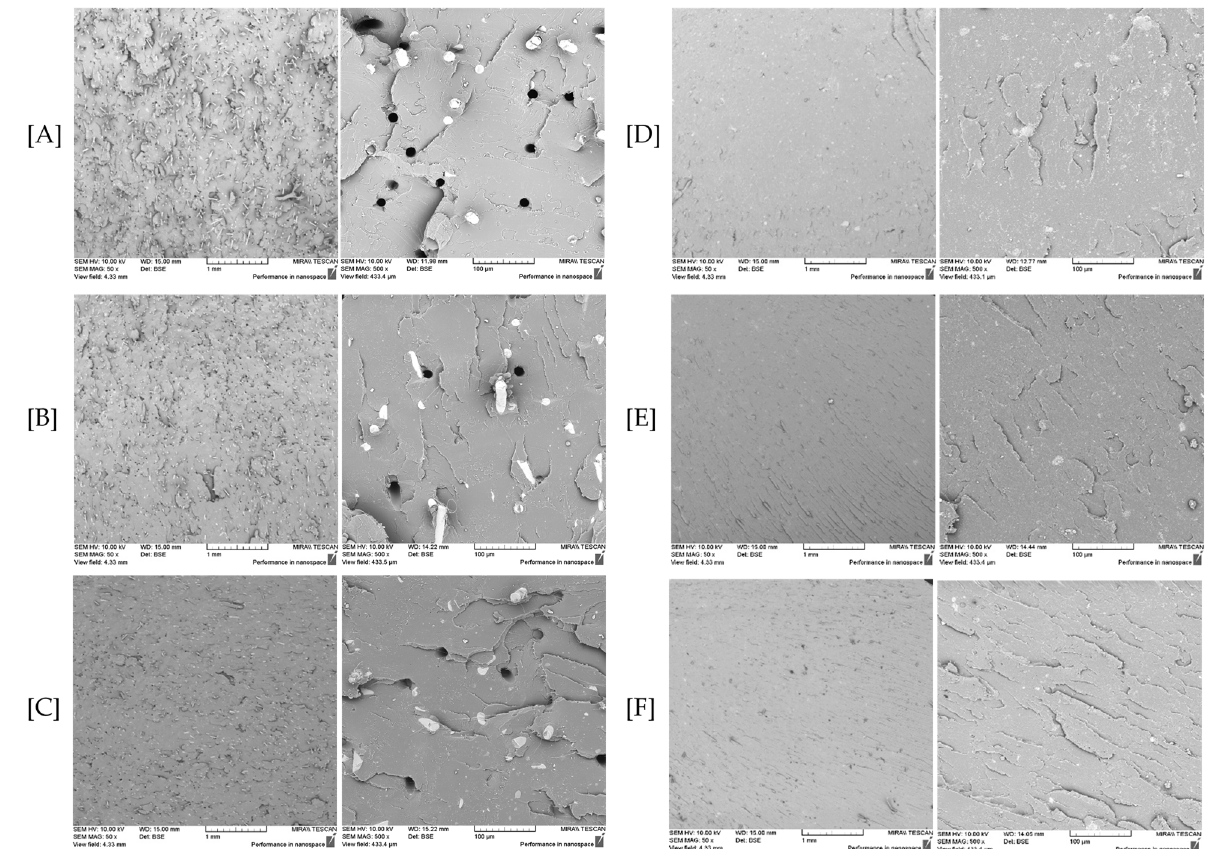
Figure 8. SEM images of the impact fracture of NFRCs. (L) 50 × magnification, (R) 500 × magnification; ( A ) 1 recycling step, ( B ) 3 recycling steps and ( C ) 6 recycling steps of BF-based NFRCs. ( D ) 1 recycling step, ( E ) 3 recycling steps and ( F ) 6 recycling steps of HNT-based NFRCs.